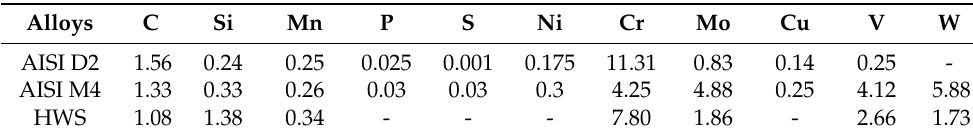
Table 8. Chemical composition of some tool steel alloys, reprinted with permission from ref.